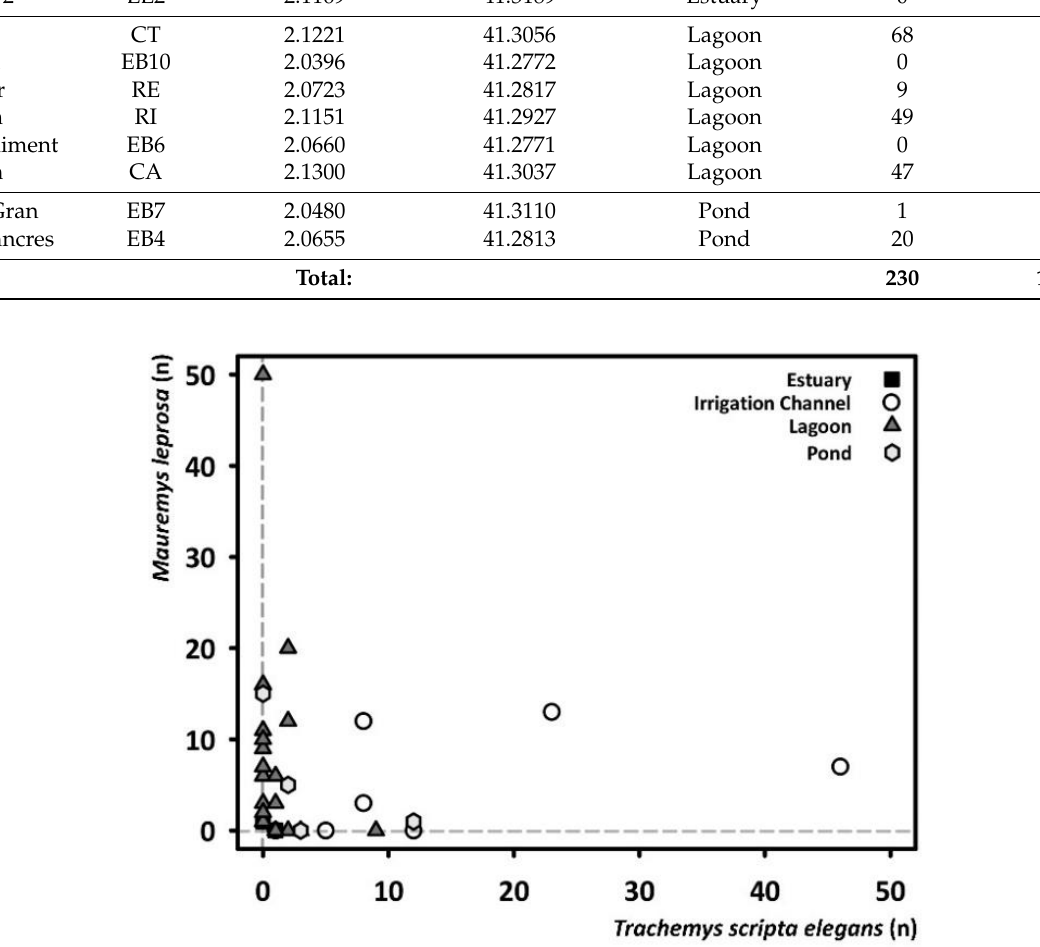
Figure 2. Abundance of each species ( M. leprosa and T. s. elegans ) at each sampling site in relation to each other. Zero values for each species are marked with a short gray dash line.